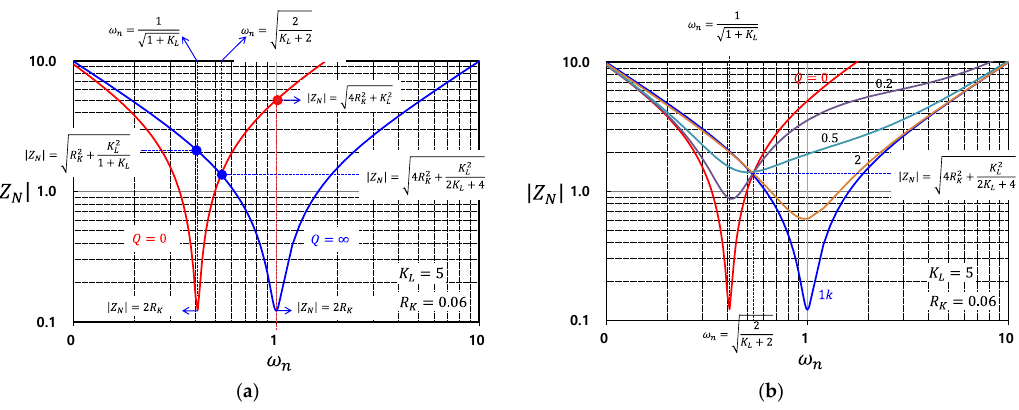
Figure 10. The frequency characteristic of the normalized input impedance |𝑍 𝑁 |: ( a ) At Q = 0 and infinity; and ( b ) for various values of Q . Table 2. Normalized input impedance 𝑍 𝑁 of the converter, according to each normalized frequency 𝜔